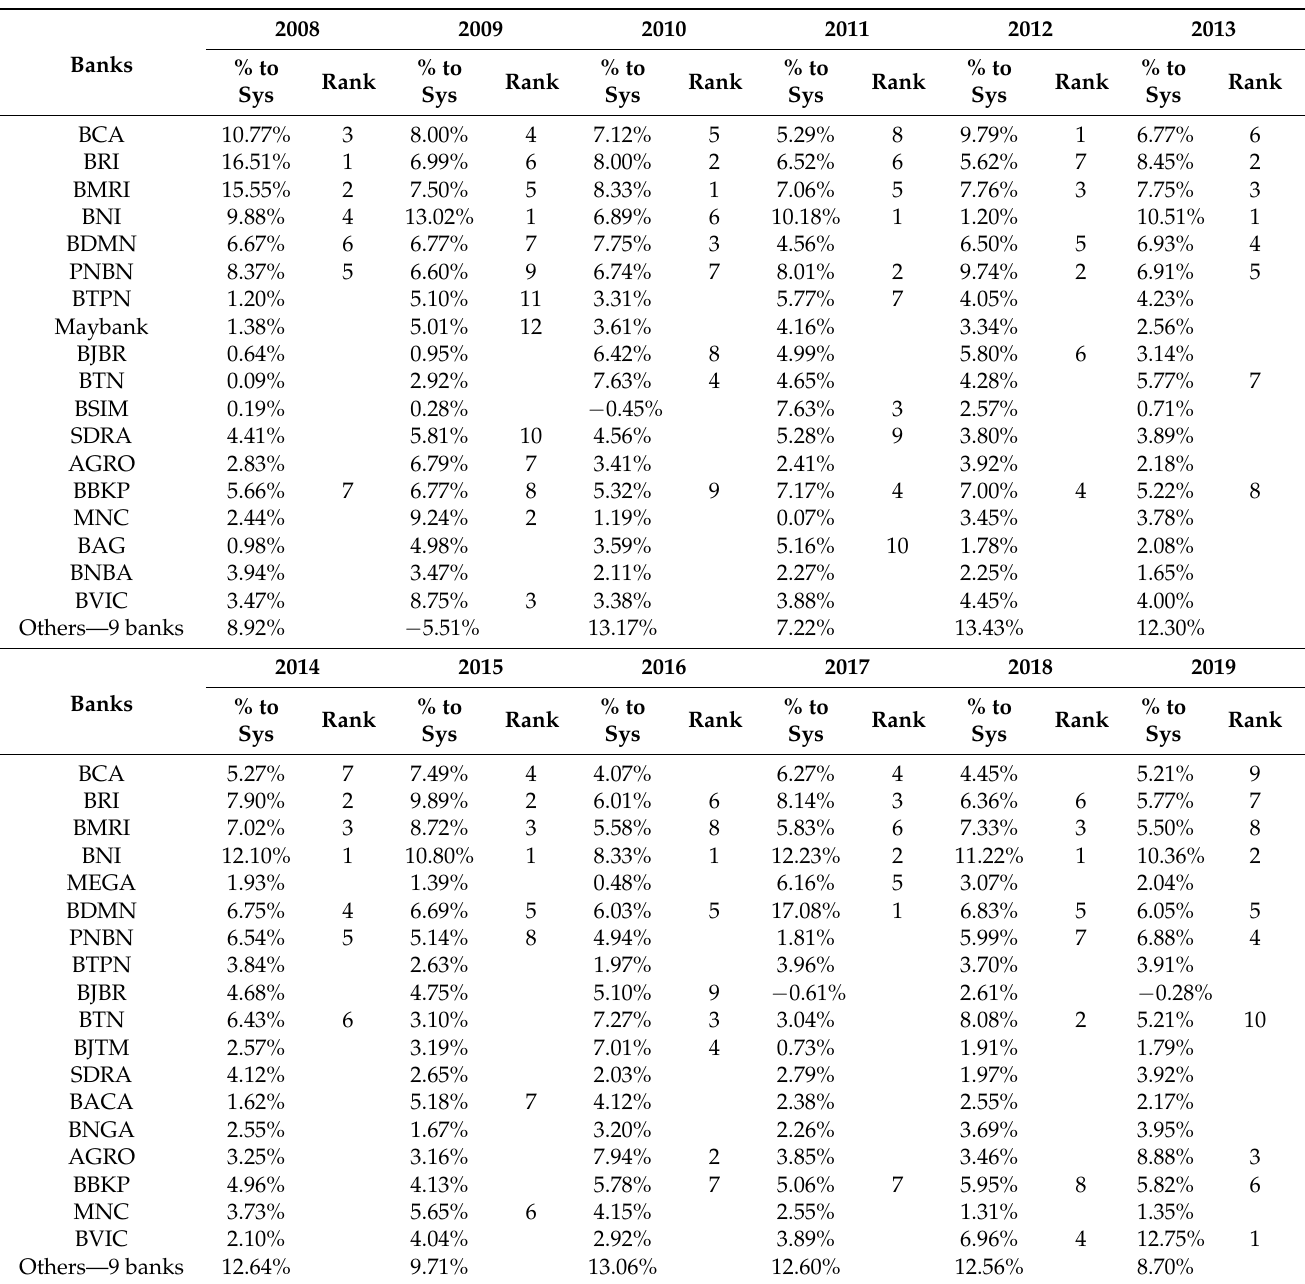
Table 6. Marginal expected